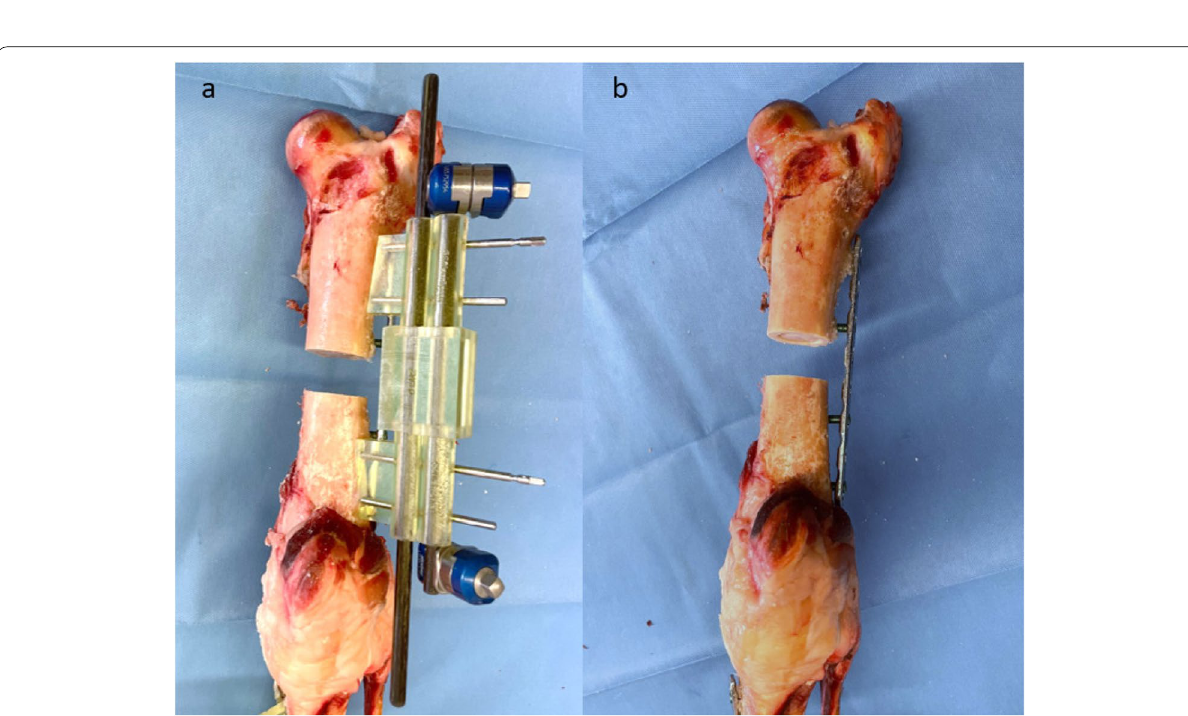
Fig. 5 Femoral surgical site after reduction and plate fixation. a displays a frontal view of the femoral surgical site after defect creation, reduction and plate fixation with the reduction guides and bridging carbon fiber rods still in place. b shows the final result with the reduction guides and pins